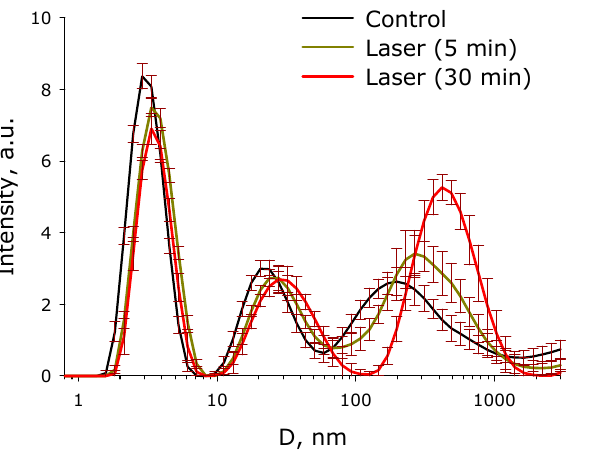
Figure 8. Effect of laser irradiation time on the viscosity of an aqueous solution of BSA at different shear rates ( n = 3, Mean).